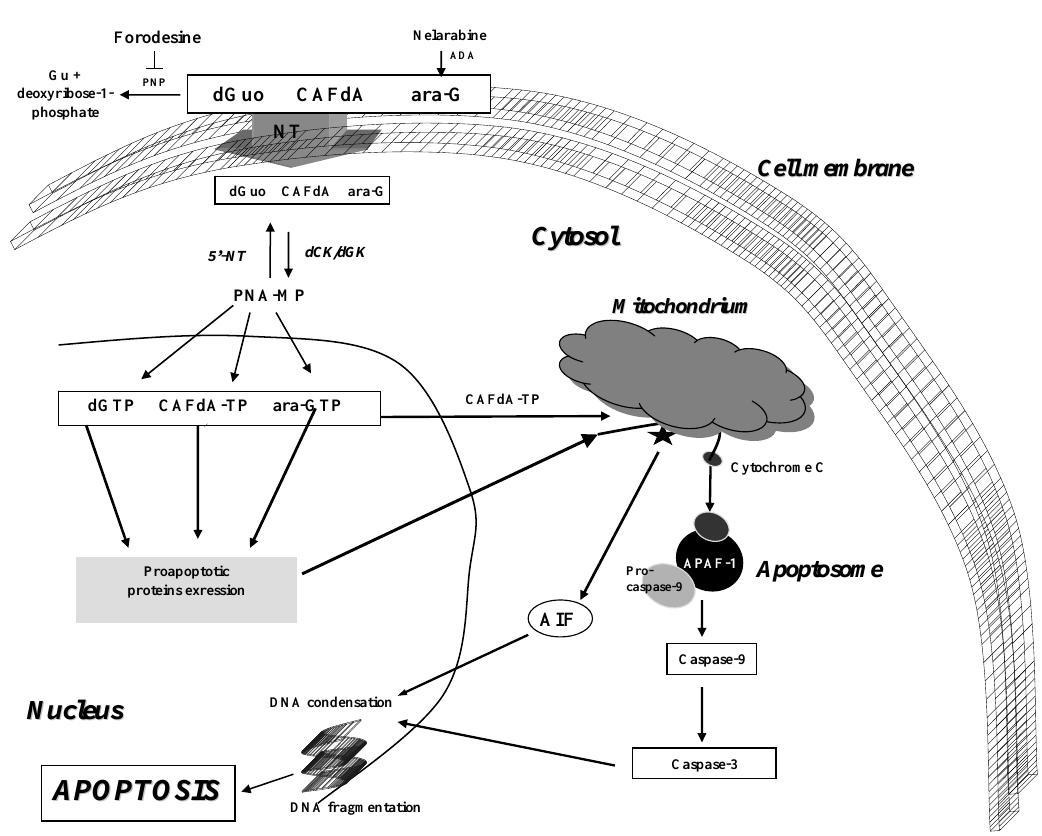
Figure 4. Mechanism of clofarabine, nelarabine and forodesine